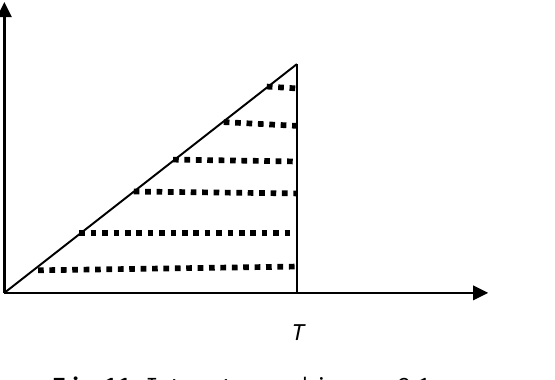
Fig. 11. Interest earned in case 2.1 Fig. 12. Interest payable in case